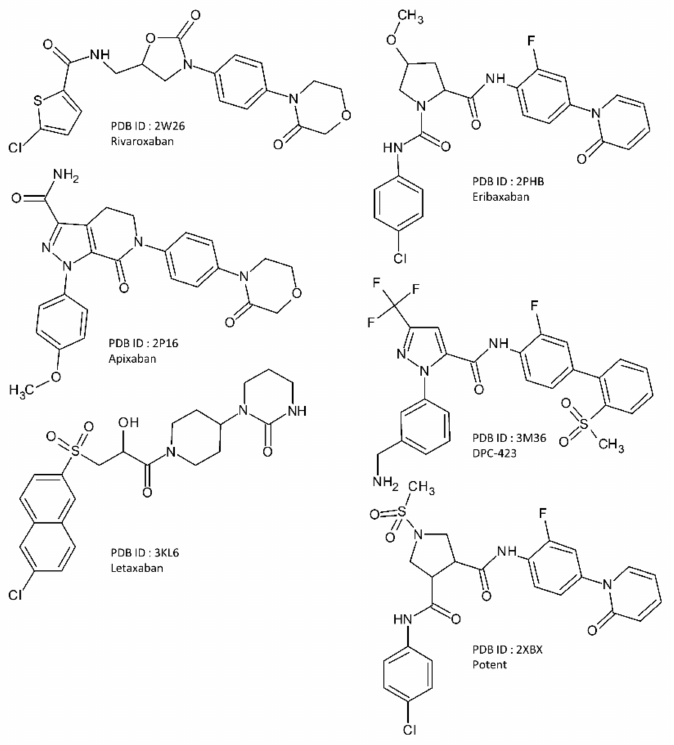
Figure 9. The 2D chemical structure of the co-crystallized FXa